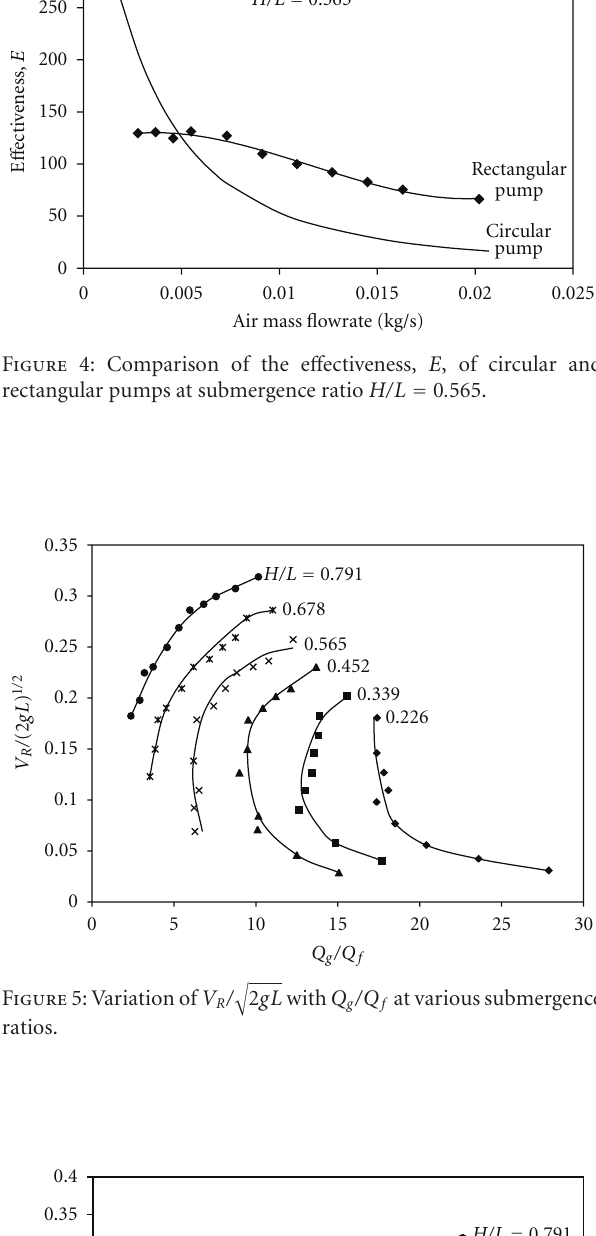
Figure 5: Variation of V R / ratios.